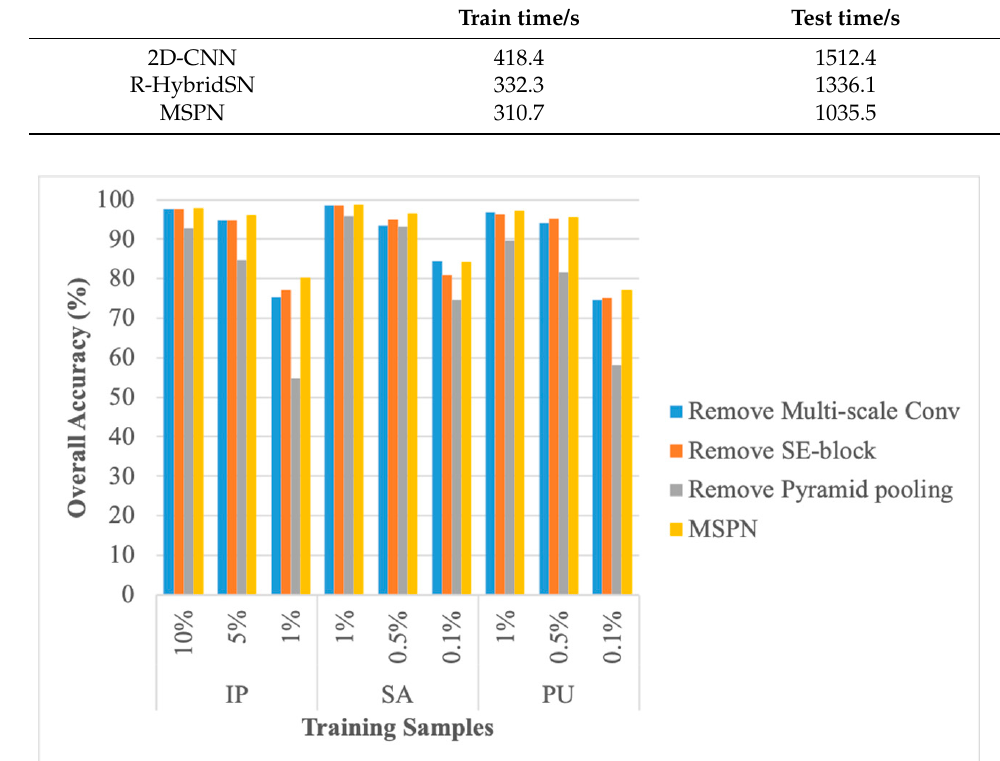
Figure 6. OA of the MSPN while removing each module separately.